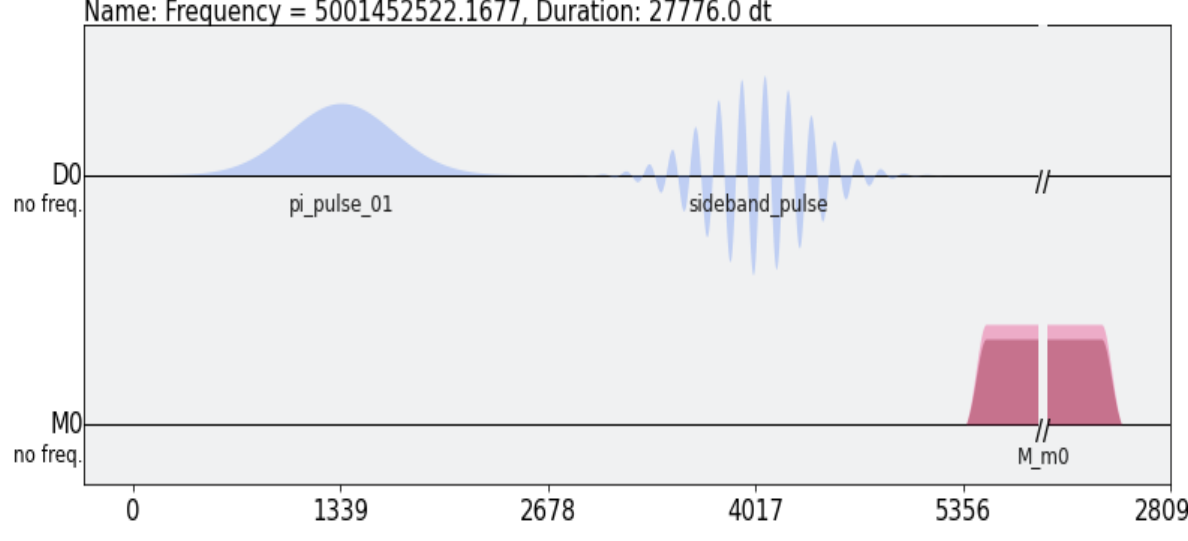
Figure 5. Main and sideband pulse for sweeping for the 1 → 2 transition frequency.